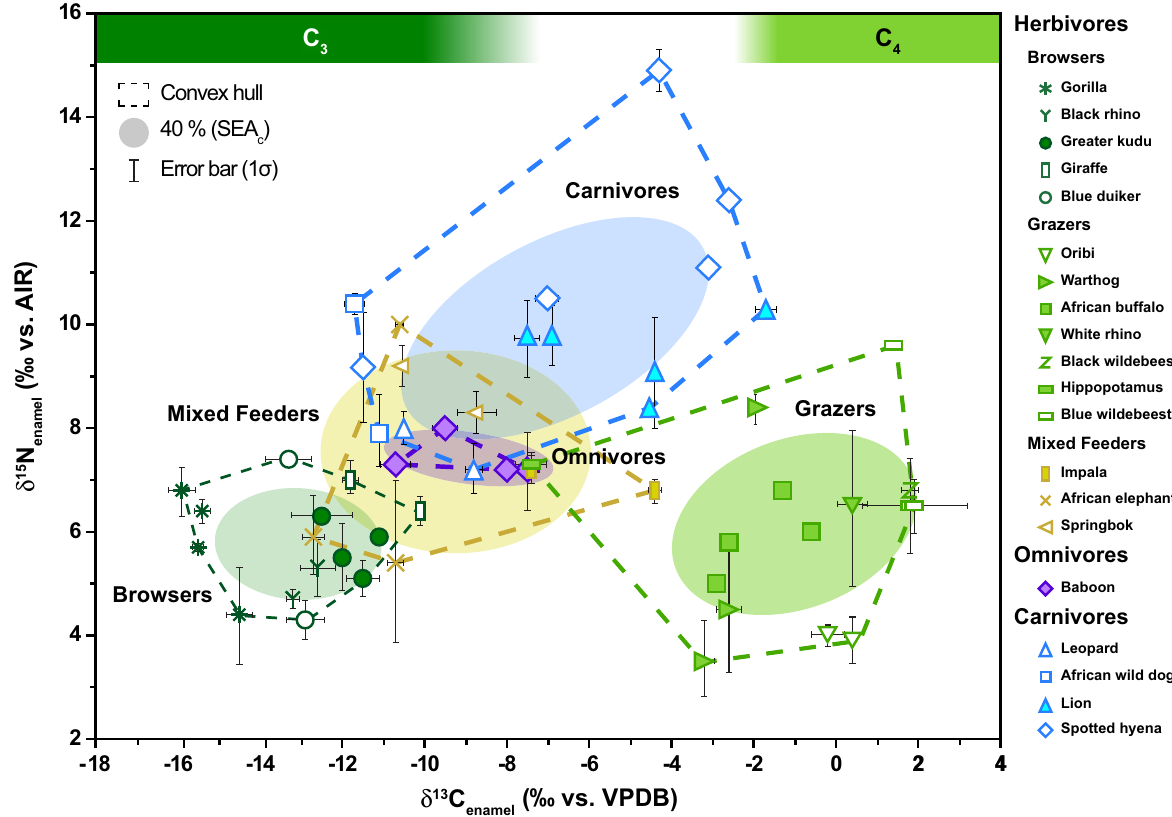
Fig. 3 Cross plot of δ 13 C enamel and δ 15 N enamel values for all modern African mammals. Browsing (dark green), grazing (light green), and mixed feeding (brown-green) herbivores, omnivores (purple), and carnivores (blue) are indicated with color and taxa are indicated with symbols. Dashed lines for convex hulls represent the full range of variation, and shaded ellipses indicate 40% of estimated standard ellipse areas (SEA C ). Herbivores and omnivores have relatively low δ 15 N enamel values and generally plot in the lower half of the fi gure, while carnivores have higher δ 15 N enamel values and plot in the top half of the fi gure. Green shaded bars at the top of the fi gure indicate tooth enamel δ 13 C isotopic ranges for modern herbivores corresponding to pure C 3 (browsing) and C 4 (grazing) resource utilization (after Cerling et al. 104 and corrected for the fossil-fuel-induced shift in the δ 13 C of atmospheric CO 2 for the period of 1950 – 1970).